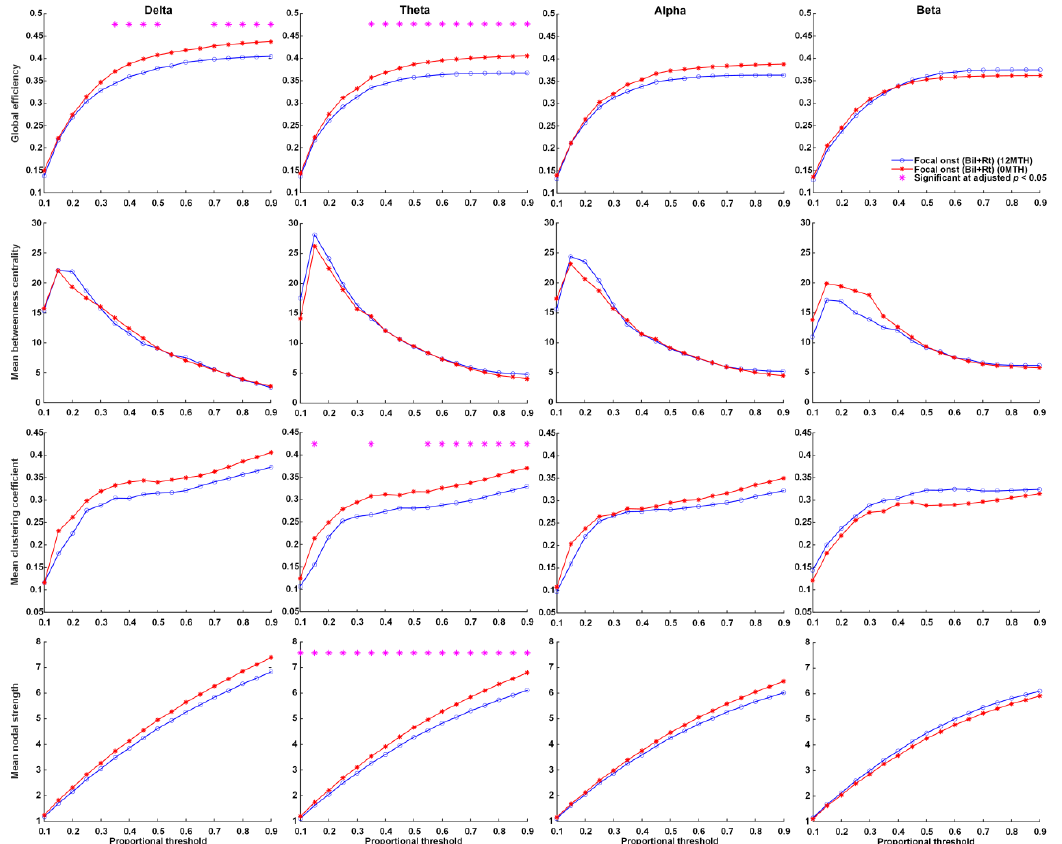
Figure 3. Parameters related to graph theory-based electroencephalographic connectivity in patients presenting FOS with right or bilateral EEG lateralization at KD initiation and after 12 months of KDT. Asterisks denote statistically significant differences (* adjusted p < 0.05).